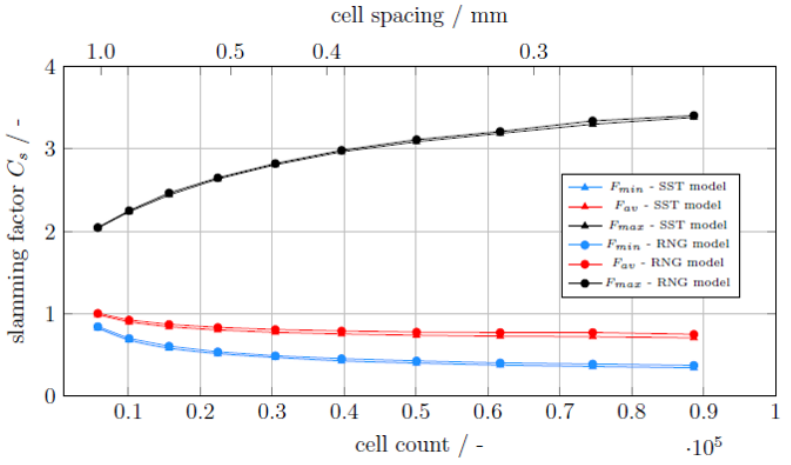
Figure 10. Influence of the selected turbulence model on the computed result for the slamming